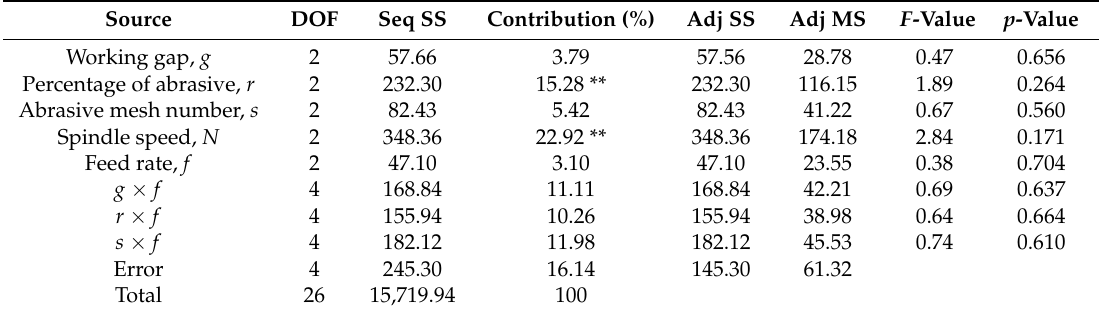
Table 5. Results of pooled ANOVA of ∆ R a for